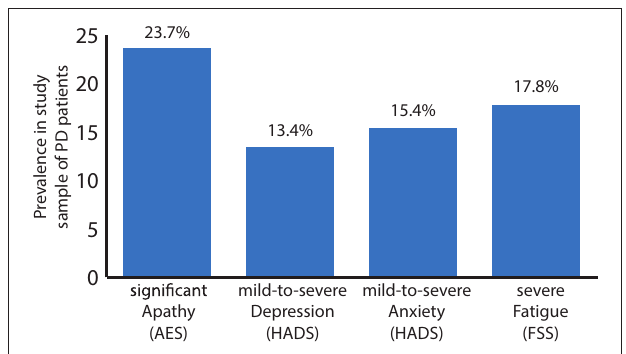
FIGURE 1 | Prevalence of clinically significant apathy (AES total score ≥ 40; 23.7%), mild-to-severe depression (HADS partial score ≥ 10; 13.4%), mild-to-severe anxiety (HADS partial score ≥ 10; 15.4%), and severe fatigue [FSS total score ≥ 5; 17.8%; significant fatigue (FSS total score of ≥